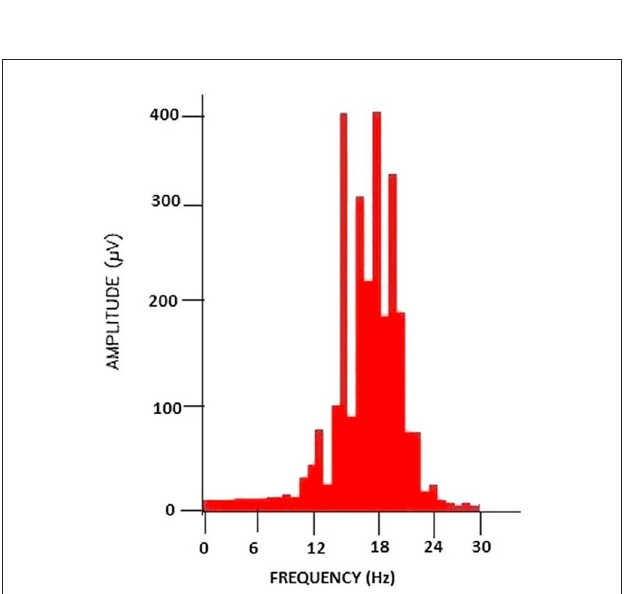
FIGURE5 PSD analysis of the filtered brain signal. Taken from Chakladar and Chakraborty (2018).